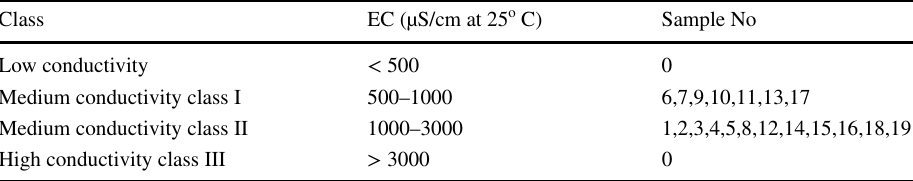
Table 8 Classification on the basis of EC (After Sarma and Narayanaswamy